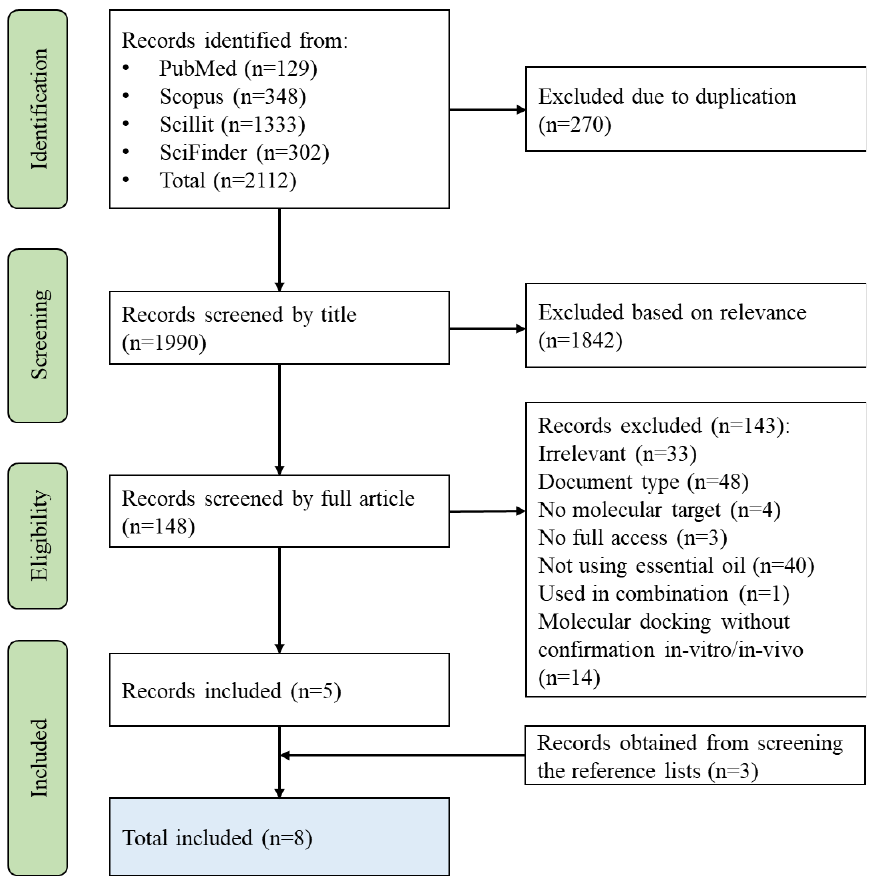
Figure 1. PRISMA diagram for the screening and selection process of the published literatures.